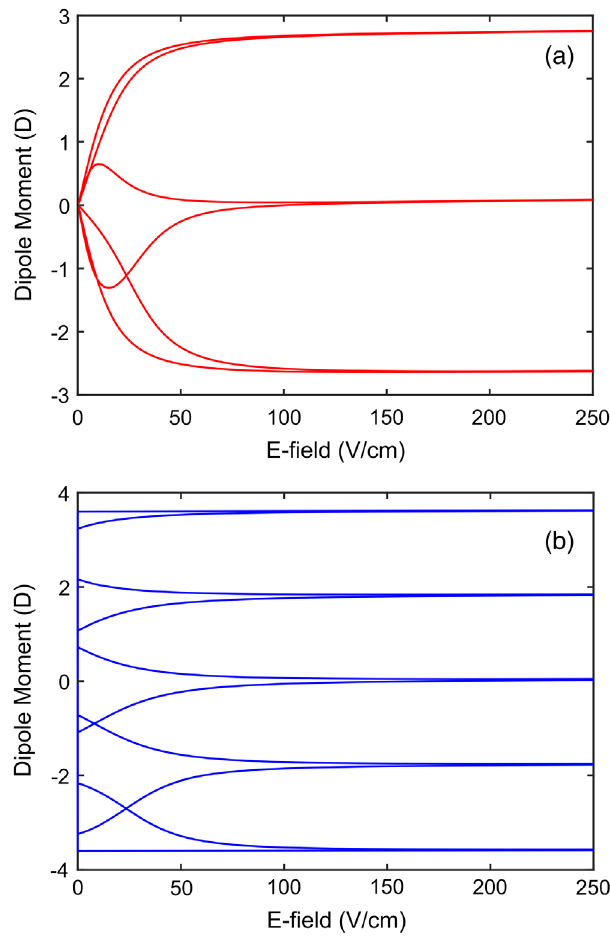
FIG. 7. Ground-state, lab-frame dipole moments of CaSH. (a) Dipole moments in the 1 10 = 1 11 asymmetry doublet. (b) Dipole moments in the 2 20 = 2 21 asymmetry doublet. Full alignment is achieved at fields close to or less than 100 V = cm for 1 1 and less K c than 1 V = cm for 2 2 . Note that, even at the maximum fields K c shown in these plots, diatomic CaF would only achieve a lab- frame dipole moment of about 0.05